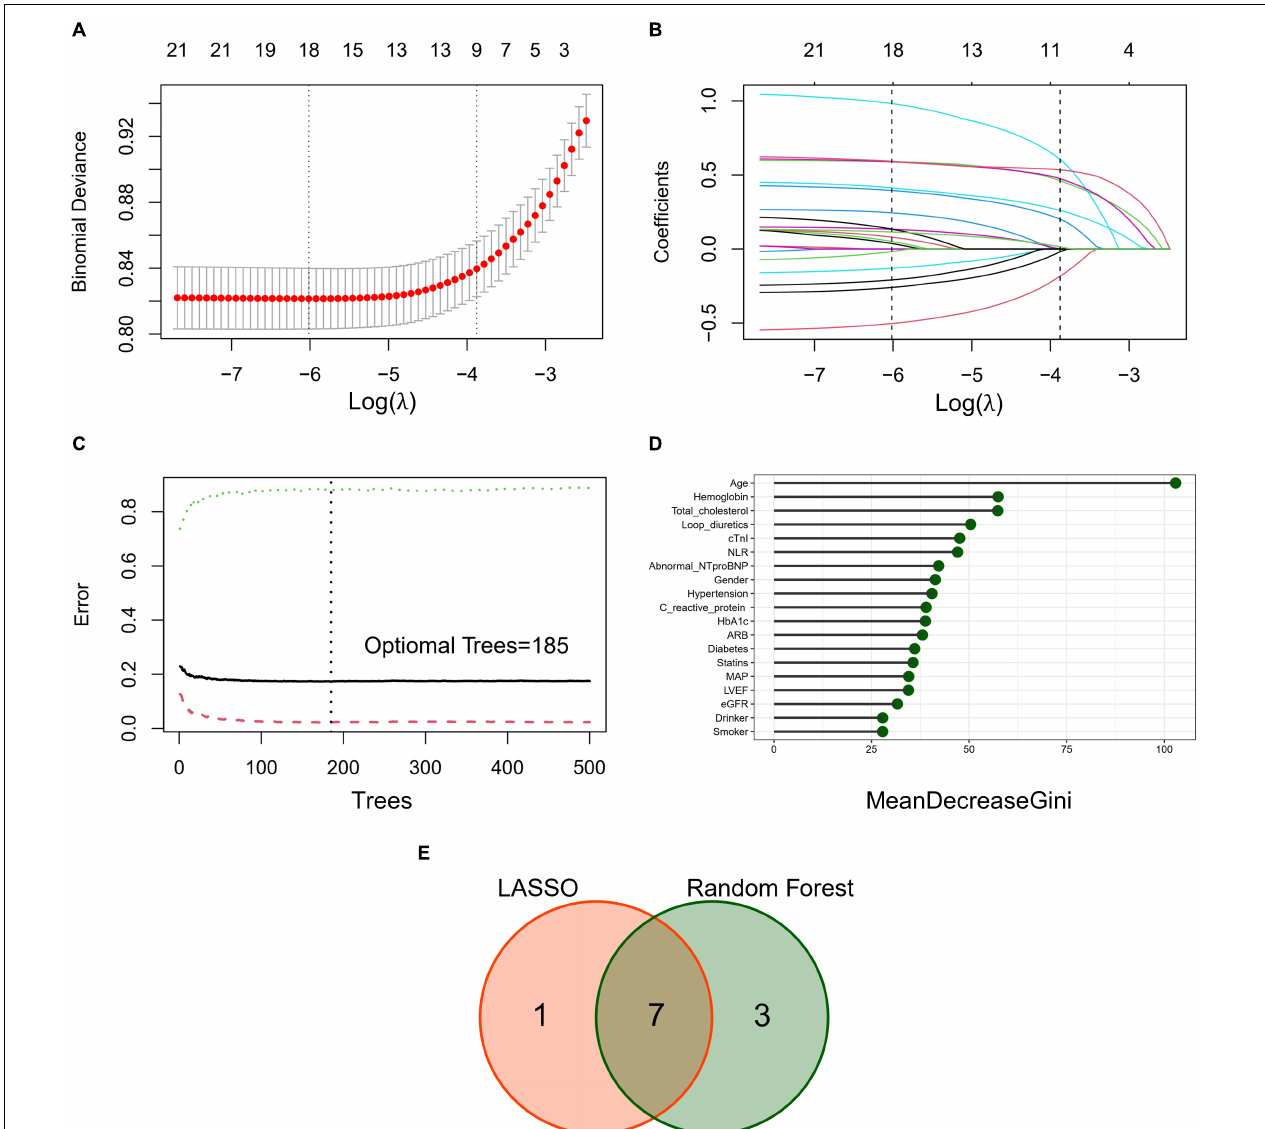
FIGURE 2 | Predictive variables selection by the least absolute shrinkage and selection operator (LASSO) algorithm and random forest (RF) algorithm. (A) Identification of the optimal penalization estimate of lambda. Tenfold cross-validation with a minimum error criterion was used to determine the optimal penalization estimate of lambda in the LASSO regression. (B) The LASSO estimate profile of predictive variables. The left vertical line indicates the optimal lambda location, and the right vertical line indicates 1 standard error of optimal lambda. (C) Error convergence curve of the random forest model (500 trees). Optimal number of trees ( n = 185) was determined according to the minimal error rate of fivefold cross-validation. (D) Importance ranking of candidate predictors in the random forest model. Mean decrease Gini index was calculated to define the importance of candidate predictors. (E) Venn diagram to determine identical predictors from LASSO and RF algorithm. A total of 7 identical predictors were determined from LASSO algorithm (8 variables) and RF algorithm (top 10 variables).